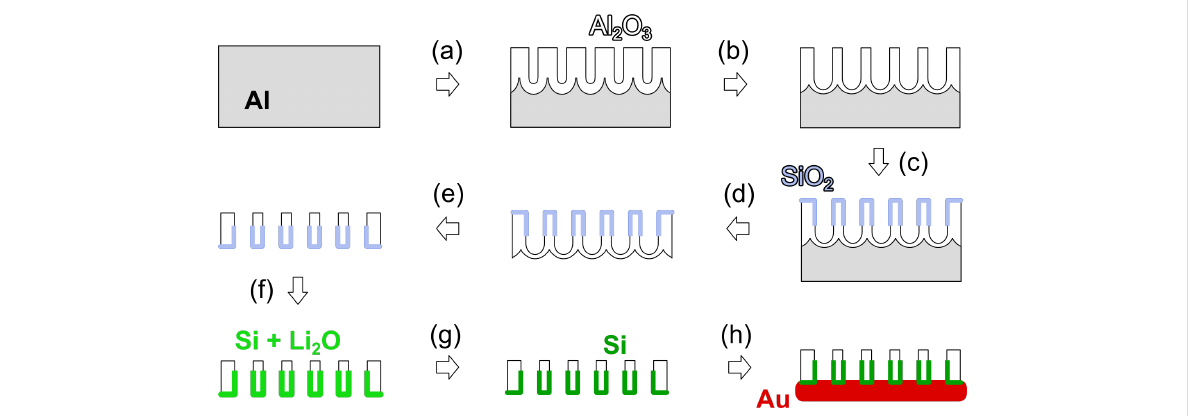
Figure 2: Preparative scheme: (a) – e – , H 2 C 2 O 4 /H 2 O, 7 °C (two-step anodization); (b) H 3 PO 4 /H 2 O, 45 °C (pore widening); (c) H 2 N(CH 2 ) 3 Si(OEt) 3 , H 2 O, O 3 /O 2 , 150 °C (ALD); (d) CuCl 2 /HCl/H 2 O, 20 °C; (e) H 3 PO 4 /H 2 O, 45 °C; (f) Li, 670 °C; (g) HCl/H 2 O, 20 °C; (h) Au sputter, 20 °C. Note that despite the impression which may emanate from this cross-section representation, the aluminum oxide framework remains reticulated and contin- uous throughout (see Figure